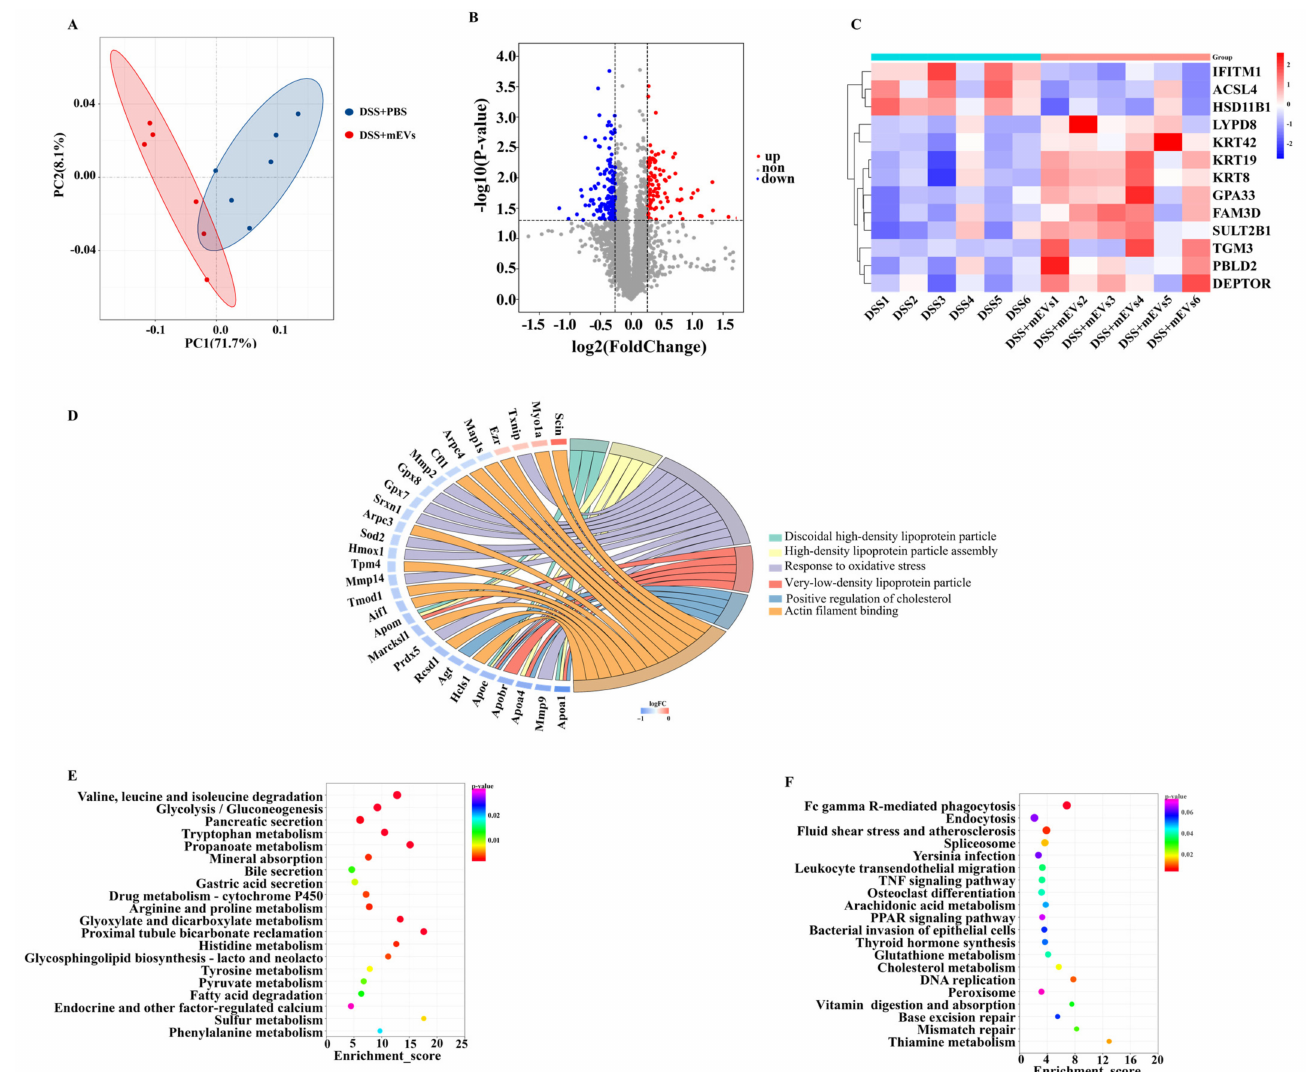
Figure 4. Tandem mass tag (TMT) mass spectrometry of the distinct proteomic signatures of colons in DSS − induced colitis murine model. ( A ) Principle component analysis (PCA) of the protein expression profiling in DSS+PBS and mEV − fed group samples. ( B ) Volcano plots of the alteration in colonic proteins in response to mEVs (FC ≥ 1.2/FC ≤ 0.84, p < 0.05). ( C ) The heatmap of the 13 differently expressed proteins. ( D ) The enrichment chord plot of differentially expressed proteins (the number of differentially expressed proteins in every sample were more than 3 and less than 500. ( E ) The up − regulated KEGG pathways in response to mEVs. ( F ) The down − regulated KEGG pathways in response to